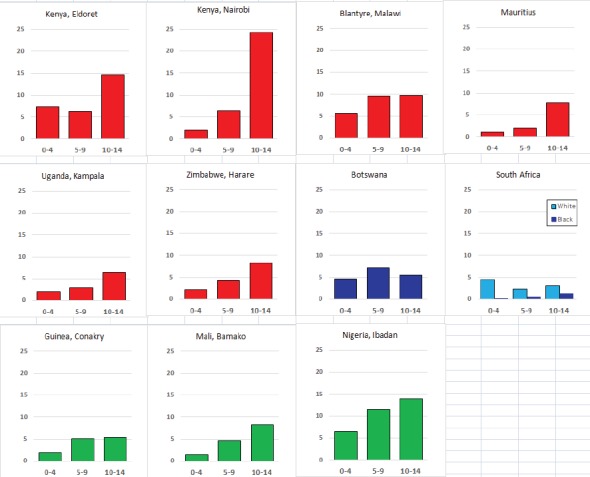
Age-specific histograms—carcinomas.